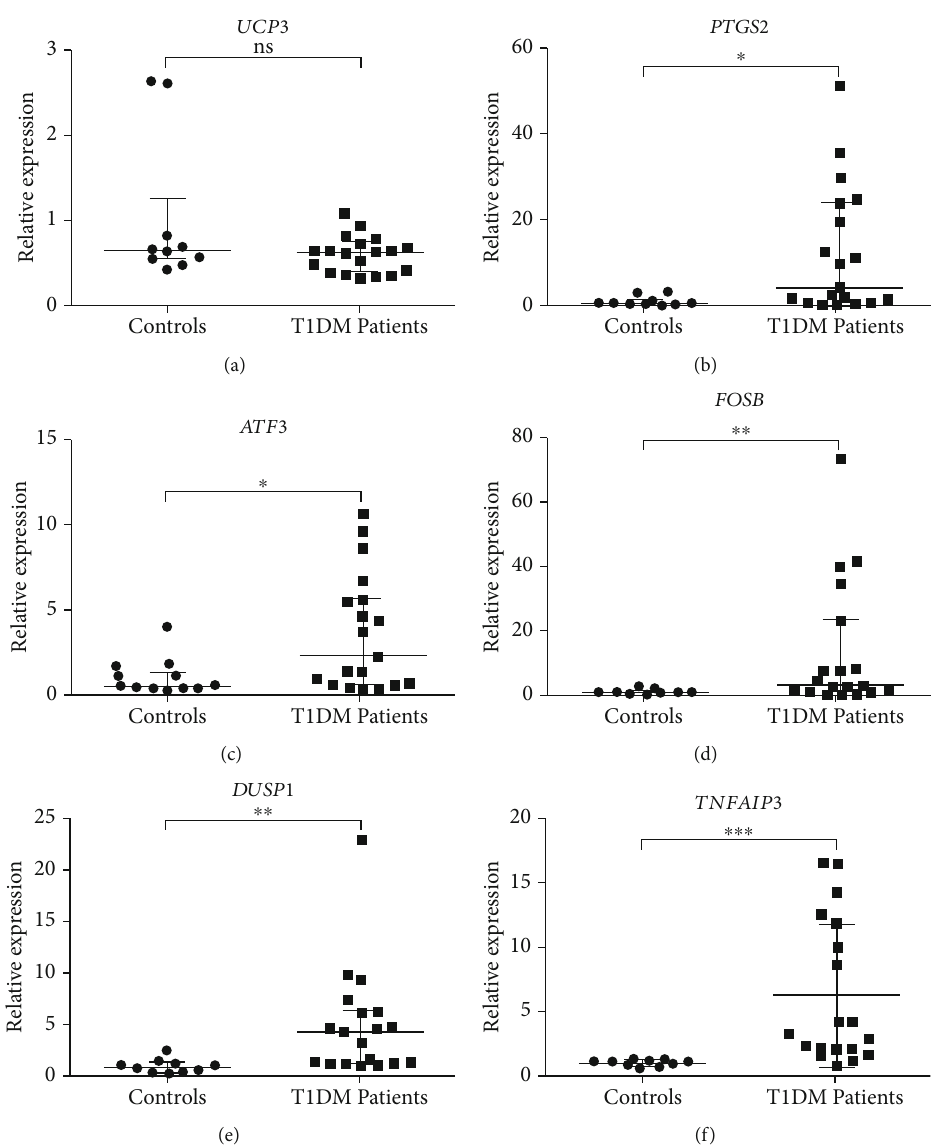
Figure 2: Relative expression of genes associated with oxidative stress response and DNA repair in PBMCs of T1D patients compared to the control group, evaluated by qRT-PCR. For all genes, the assay was performed for 19 T1D samples and 10 control samples. For FOSB (d), two controls were excluded (Co_01 and Co_11). These samples were the same used for the microarray method. Two endogenous genes were used to normalize the expression values: GAPDH and HPRT1 . For the UCP3 (a), PTGS2 (b), ATF3 (c), FOSB (d), and DUSP1 (e), bars represent the median and interquartile range. For the TNFAIP3 (f), bars represent the mean ± standard deviation . ∗ indicates statistically signi fi cant values for p < 0 : 05 ; ∗∗ p < 0 : 01 ; ∗∗∗ p < 0 : 001 ; ns: not signi fi